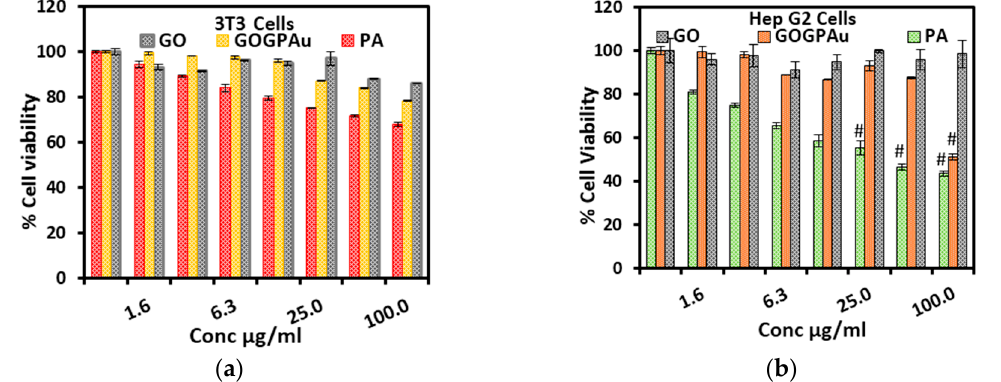
Figure 6. ( a ) Cytotoxicity results of pure GO nanosheets, pure protocatechuic acid and protocatechuic acid loaded on GO/Gd nanocarrier after surface coating with gold nanoparticles (GAGPAu) dosed in normal fibroblast cell lines (3T3); ( b ) cytotoxicity results of pure GO nanosheets, pure protocatechuic acid and protocatechuic acid loaded on GO/Gd nanocarrier after surface coating with gold nanoparticles (GAGPAu) dosed in cancer cell lines (HepG2).